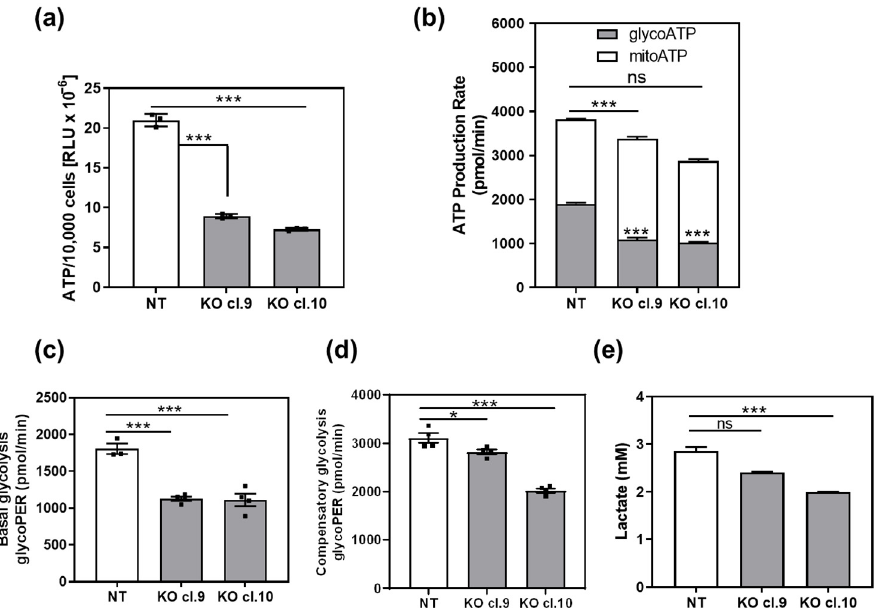
Figure 3. Depletion of ARRB1 decreases glycolysis and glycolytic ATP production rate: ( a ) total ATP per 10,000 cells in ARRB1-depleted HT176 clones (KO cl. 9 and cl.10) compared to control cells (NT). Data: means ± SEM, n = 3; *** p < 0.001 (One-way ANOVA). ( b ) Calculated glycolytic and mitochondrial ATP production rate in ARRB1-depleted HT1376 cells (KO cl. 9 and cl.10) compared to corresponding controls (NT). Data: means ± SEM, n = 3 or 4; *** p < 0.001 (glycoATP, KO vs. NT), *** p < 0.001 (mitoATP, KO vs. NT) (Two-way ANOVA). Total ATP: (NT vs. Cl.9, ** p < 0.01; NT vs. Cl.10, *** p < 0.001) ( c ) Basal glycolytic proton efflux rate (PER) in ARRB1 depleted HT1376 cells (KO cl. 9 and cl.10) compared to corresponding controls (NT). Data: means ± SEM, n = 3 or 4; *** p < 0.001, (One-way ANOVA). ( d ) Glycolytic proton efflux rate (glycoPER) following treatment with inhibitors of oxidative phosphorylation (Rotenone and Antimycin A). Data: means ± SEM, n = 4; * p < 0.05; *** p < 0.001 (one-way ANOVA). ( e ) Quantification of lactate secreted by ARRB1-depleted cells (KO cl. 9 and cl.10) and corresponding controls (NT). Data: means ± SEM, n = 7 or 8; *** p < 0.001 (One-way ANOVA).